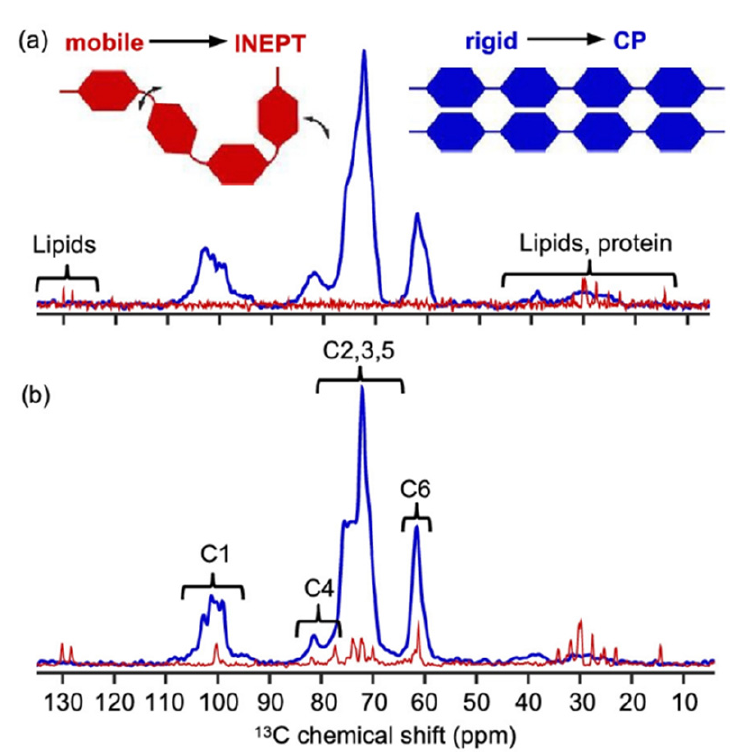
Figure 4. Polarization transfer 13 C ssNMR spectra comprised of CP and INEPT experiments on: ( a ) dry pasta strand and ( b ) soaked ones. The insert illustrates the mobile (red) and the rigid (blue) domains of the polymeric chain. Adapted with permission from Ref. [97]. Copyright 2021, Wiley.